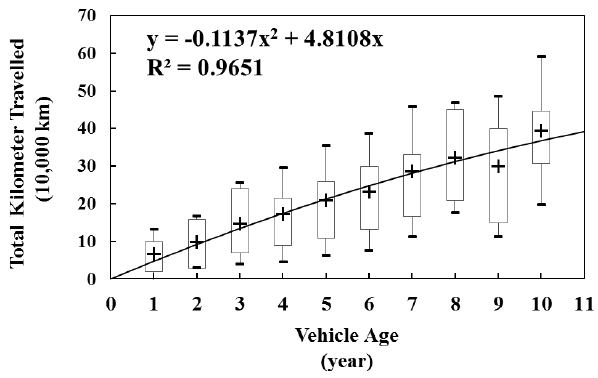
Figure 2. Accumulated traveled distance of trucks plotted against different ages (the boxes show the first and third quartiles of the total investigated numbers and the bars show the standard